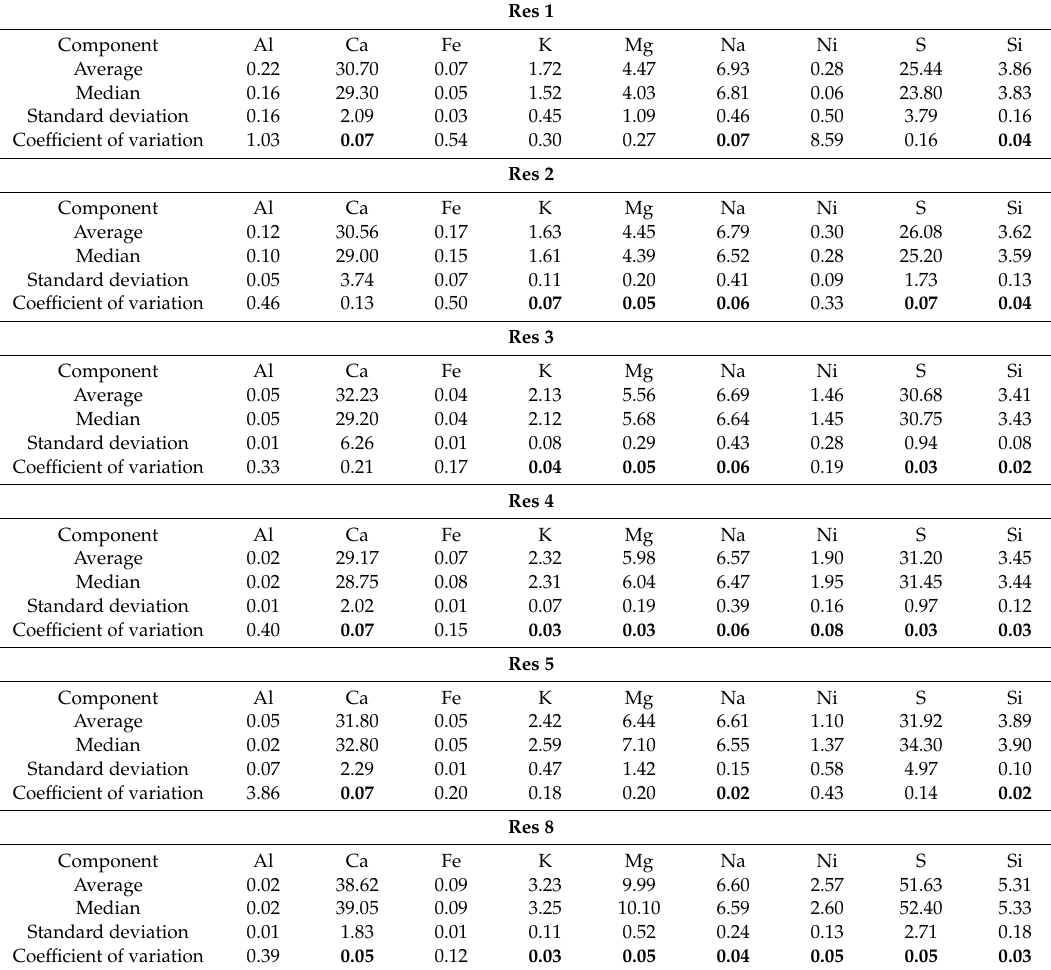
Table A1. Statistical analysis of the major component concentrations in the drainage waters